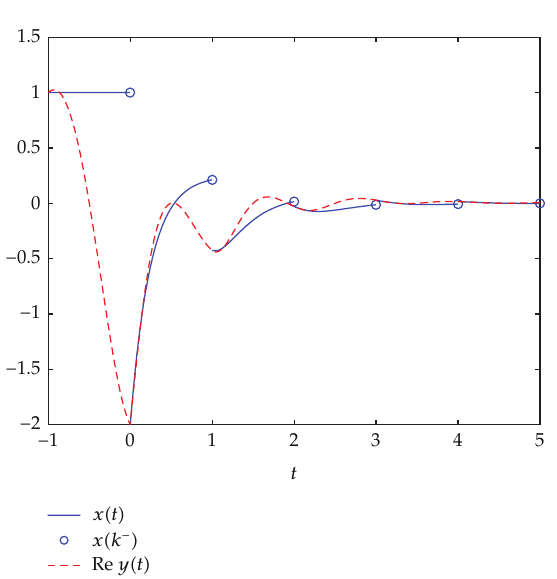
Figure 1: The analytic solution of (cid:3) 4.1 (cid:4) and the real part analytic solution of (cid:3) 4.3 (cid:4)